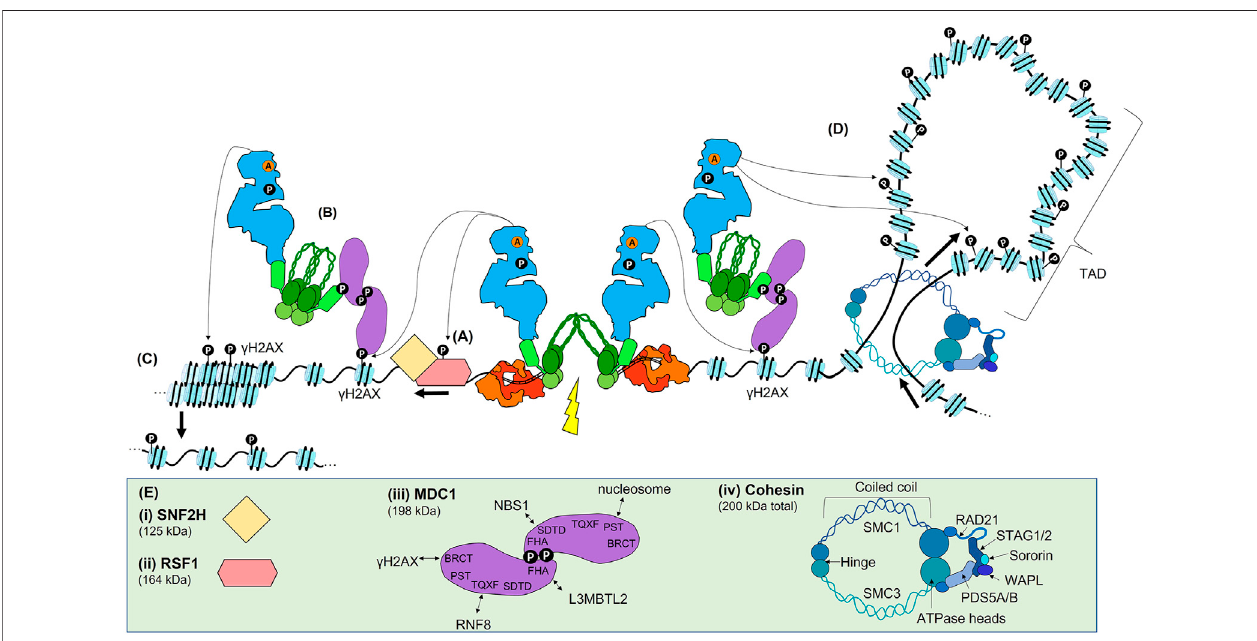
FIGURE 4 | ATM signalling in the Early DSB response. (A) Once active, ATM is recruited to sites of DSBs by an interaction with NBS1, where it phosphorylates many target proteins. One of the earliest targets is RSF1, which leads to nucleosome sliding to reveal the DNA surrounding the break. (B) ATM phosphorylates H2AX ( γ H2AX),whichallowsthescaffoldMDC1tobindviaitsBRCTdomain.AsMDC1isconstitutivelyboundtoMRN,therecruitmentofMDC1recruitsfurtherMRNandATM. (C) ATM propagates γ H2AX via continued MCD1, MRN, and ATM recruitment, leading to chromatin relaxation. (D) In addition to this method of γ H2AX propagation, γ H2AX may also be spread via proposed ‘ loop extrusion ’ mechanism. In this model, the DSB machinery blocks one direction of the normal loop extrusion that leadstotheformationofTADs. Asnucleosomesare extruded, ATMphosphorylatesH2AX withinagivenTAD. (E) Schematics orstructuresareshown totheextent of current data. (i) and (ii) schematic of RSF1 and SNF2H. (iii) MDC1 contains many SQ/TQ sites that are phosphorylated by ATM and are required for protein binding. The FHA domain allows for formation of head-to-head dimers of MDC1, and also contributes to L3BMTL2 binding. The SDTD domain interacts with NBS1. The TQXT domain interacts with RNF8. The BRCT domain interacts with γ H2AX. (iv) Cohesin is made up of the indicated